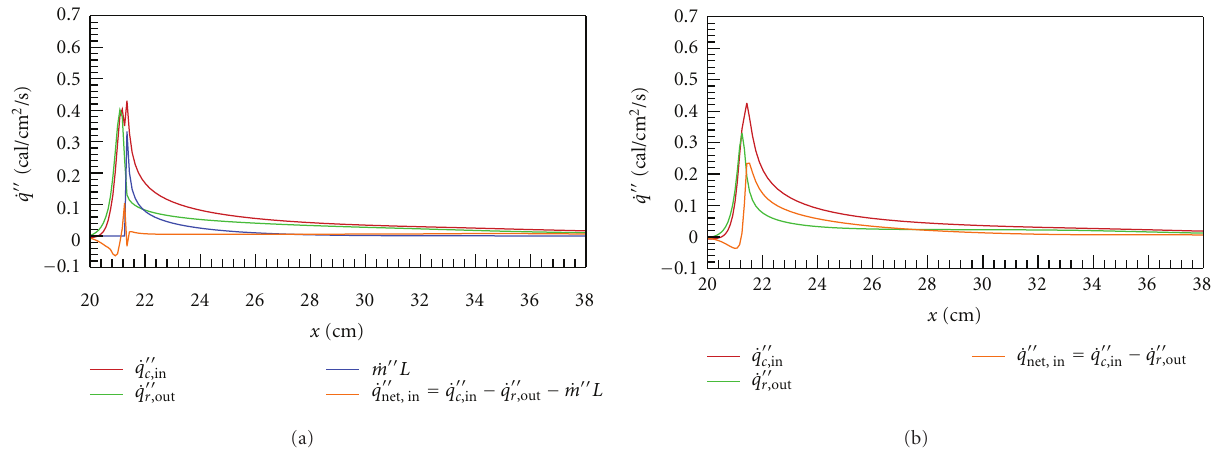
Figure 5: Heat fluxes on solid surface at the steady state (a) with the zeroth-order pyrolysis model and (b) with the first-order pyrolysis model.